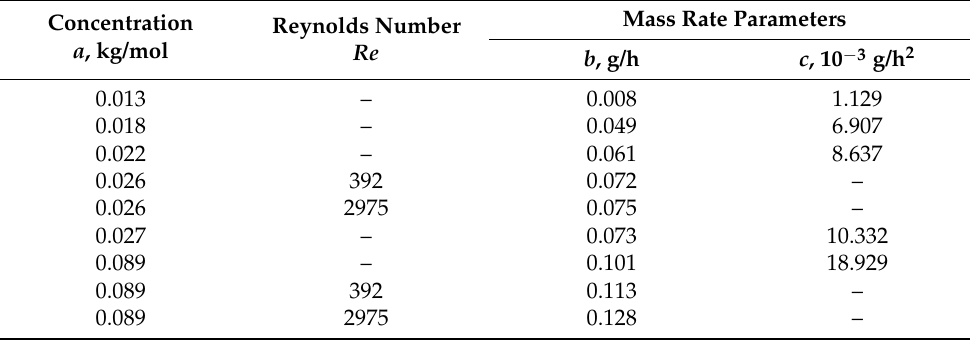
Table 2. Reaction rate constants for Zn deposition on the cathode.